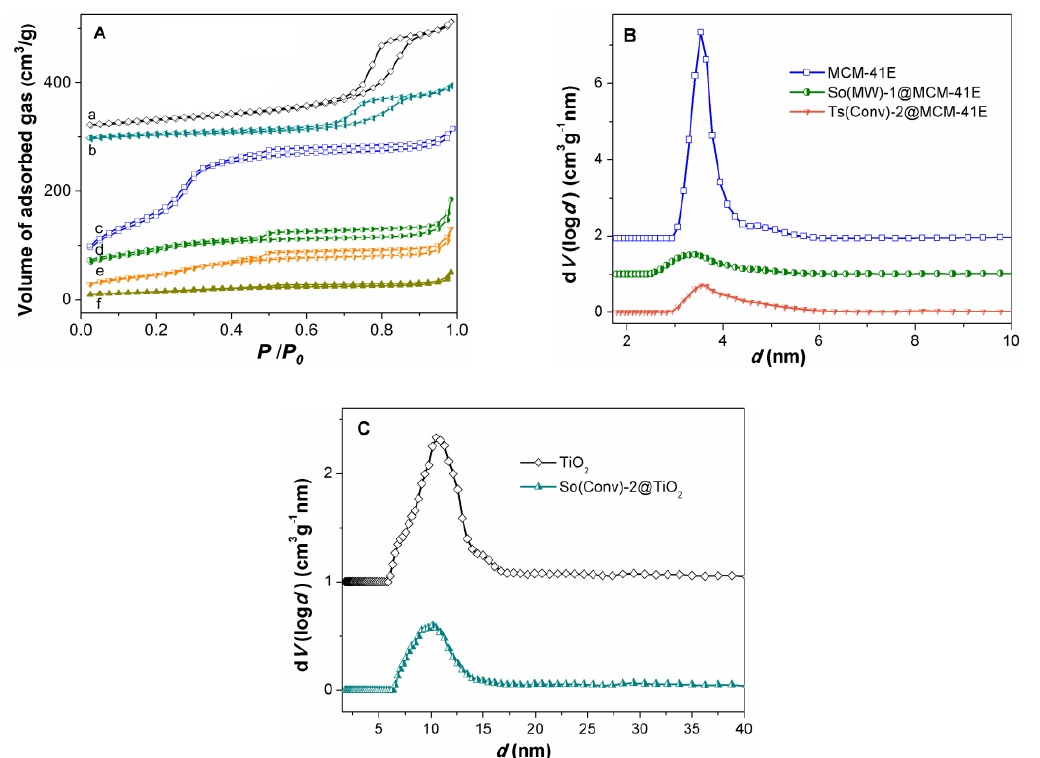
Figure 6. ( A ) N 2 adsorption–desorption isotherms for: ( a ) TiO 2 ; ( b ) So(Conv)-2@TiO 2 ; ( c ) MCM-41; ( d ) So(MW)-1@MCM-41E, ( e ) Ts(Conv)-2@MCM-41E, and ( f ) So(Conv)-2@MCM-41E. ( B ) Pore size distribution curves for MCM-41E support, So(MW)-1@MCM-41E, and Ts(Conv)-2@MCM-41E. ( C ) Pore size distribution curves for TiO 2 and So(Conv)-2@TiO 2 . Table 5. Textural features for supports and materials containing embedded extracts.